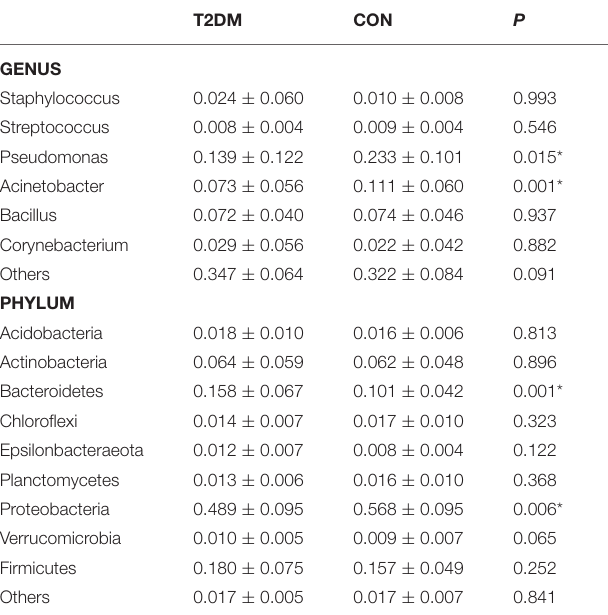
TABLE 2 | Difference of OS flora between DM group and CON